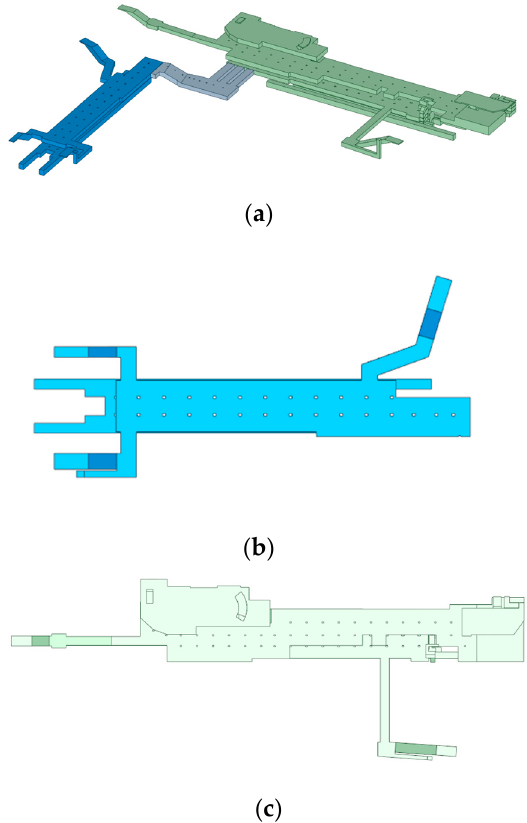
Figure 5. Geometric model diagram. ( a ) Overall elevation of the geometric model, ( b ) floor plan of line 2, and ( c ) floor plan of line 5.